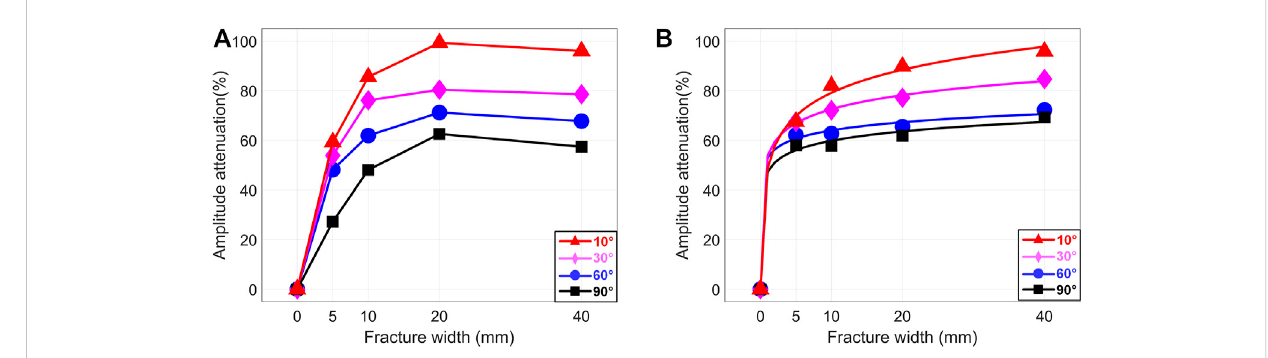
FIGURE 14 AmplitudeattenuationofP-andS-wavesversusdifferentfracturewidthsanddipangles.Thefractureis fi lledwithwater.Thefracturewidthsare0,5, 10, 20 and 40 mm. The fracture dip angles are 10 ° , 30 ° , 60 ° and 90 ° . (A) P wave; (B) S wave.